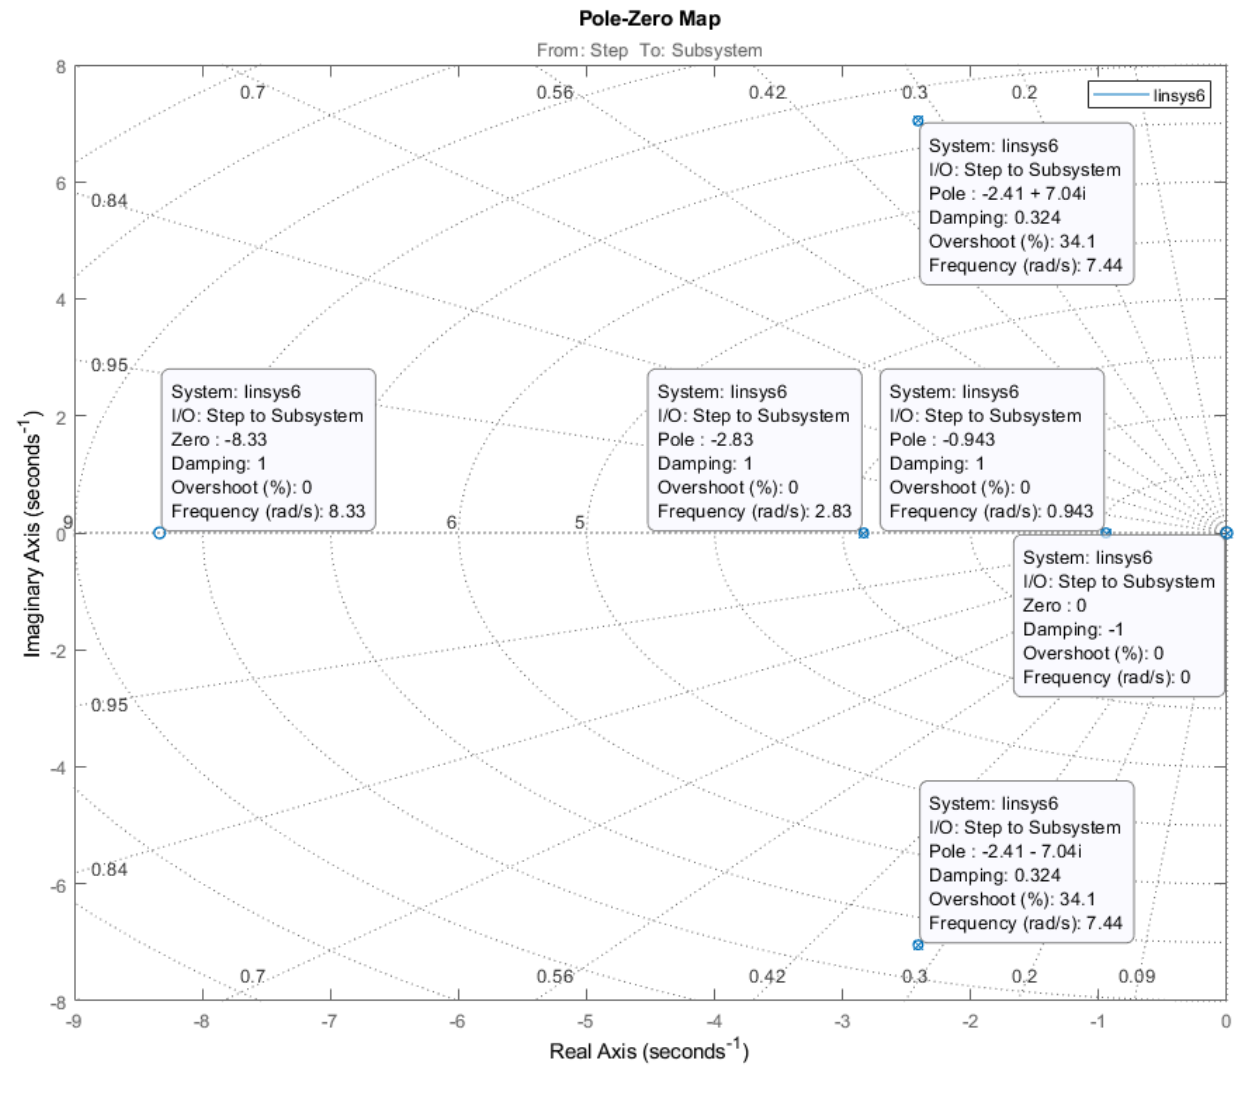
Figure A9. The zero-pole map of the position control system.